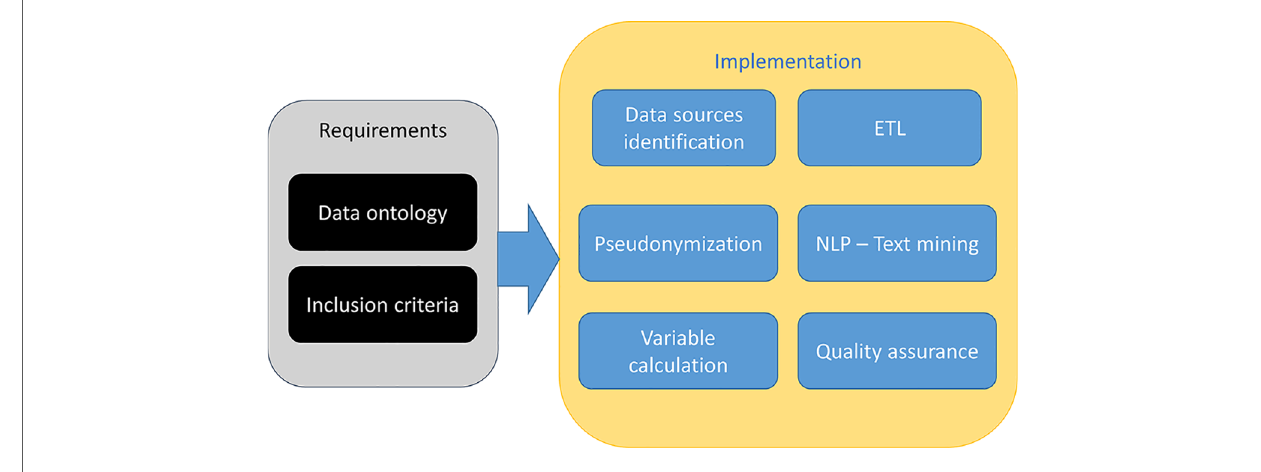
FIGURE 3 Flowchart describing cohort selection. ETL, Extract, Transform, Load; NLP, Neural Language